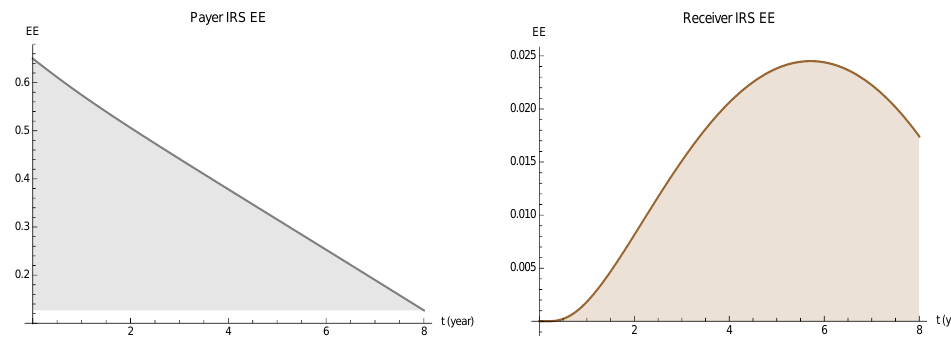
Figure 3. EEs for payer and receiver swap for t ∈ [ 0,8 ] and x 0 = 0.1.